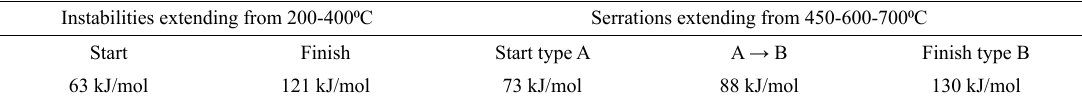
Table 2. Activation energies for the start and finish instabilities as well as serrations A and B in AISI 304 steel. Instabilities extending from 200-400⁰C